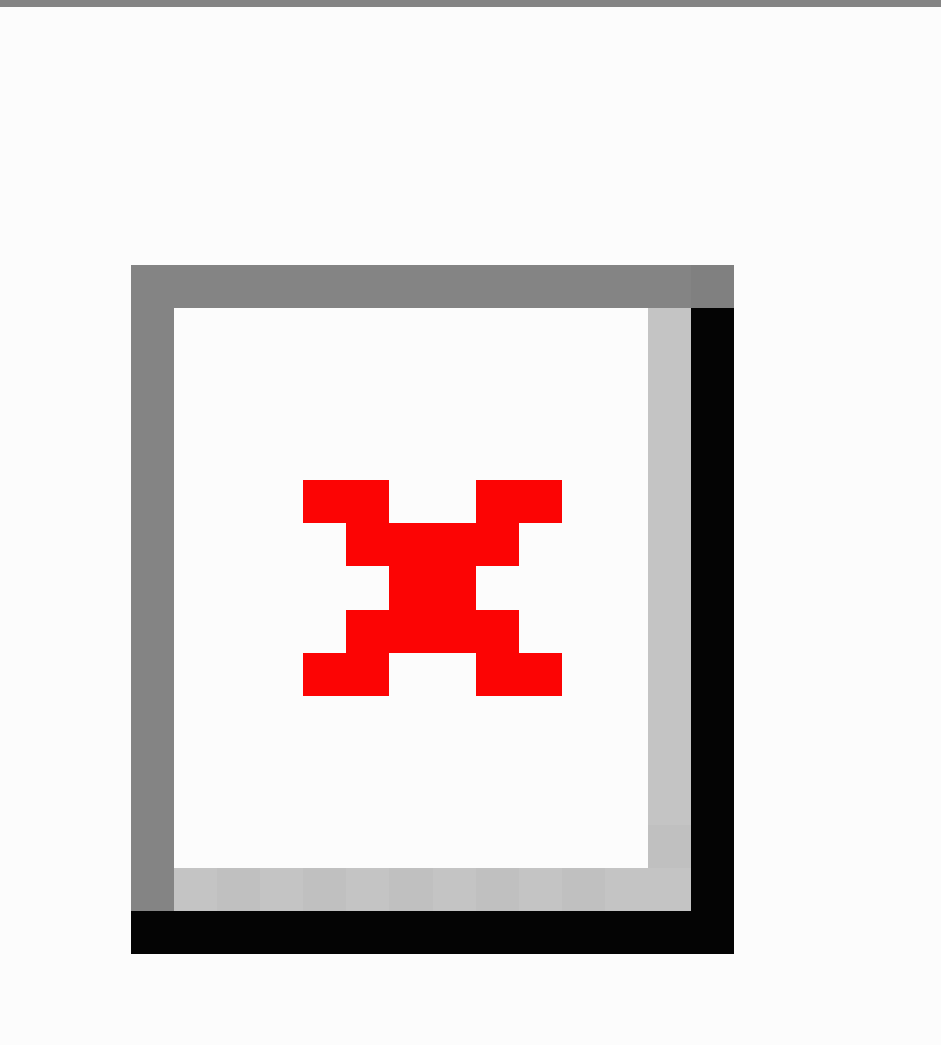
Figure 4. Four examples of patients in the PatientsLikeMe (PLM) dataset whose self-reported symptom dynamics diverge from the current consensus picture of smooth, gradual Parkinson’s disease progression. (a,b) Large, abrupt changes in the trend of symptom severity occurring over periods of a few weeks or months; (c,d) examples of single, large deviations from the trend in otherwise smooth progression. “Unknown” refers to data in which the patient did not state whether they were on treatment (on) or off treatment (off) at the time of the symptom